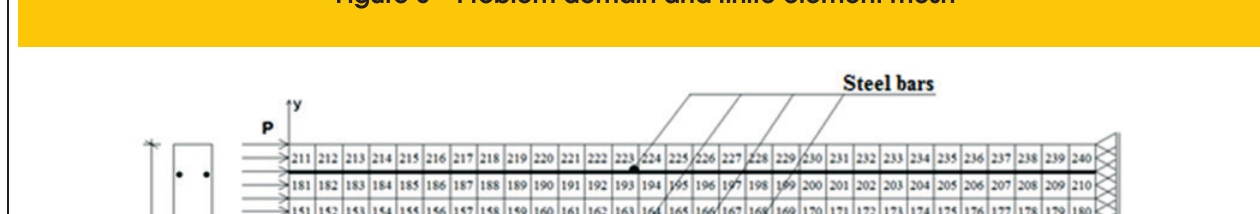
Figure 5 – Problem domain and finite element mesh